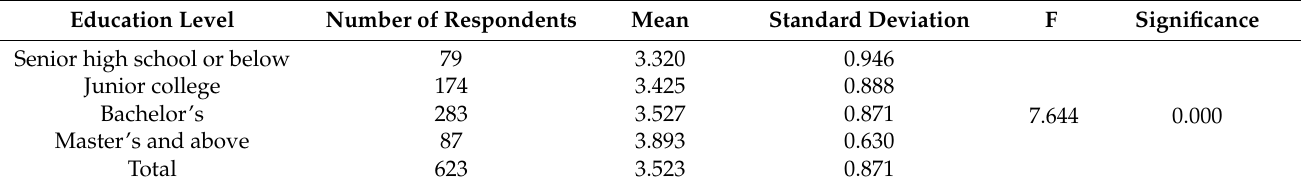
Table 15. Results of the test for differences in waste-sorting behavior between respondents with different education